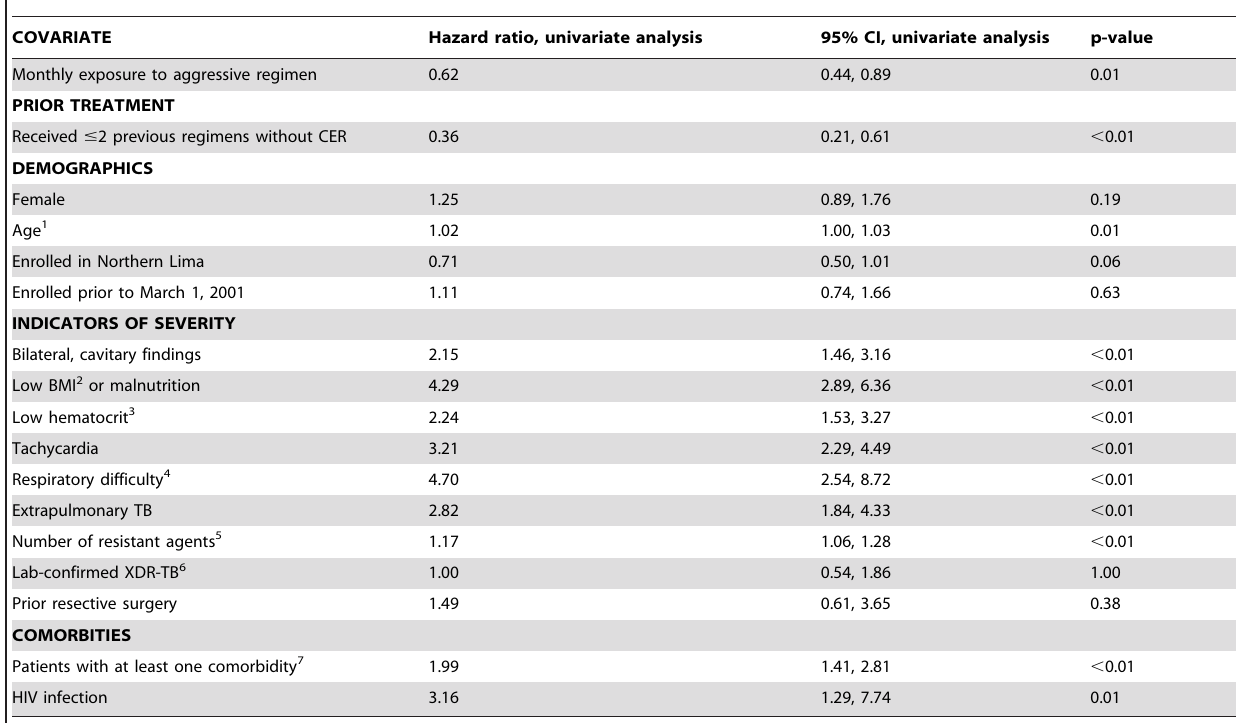
Table 3. Univariate, time-varying Cox proportional hazards analysis of aggressive regimen and time to death.